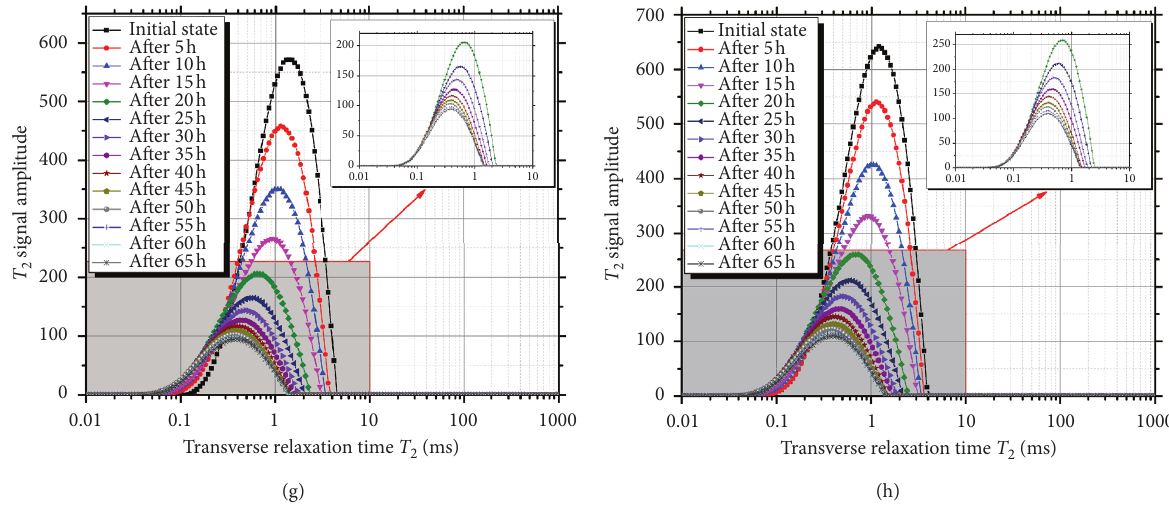
Figure 3: The variations of the T 2 spectra of artificial clayey soils during evaporation: (a) K40; (b) K60; (c) K80; (d) K100; (e) M40; (f) M60; (g) M80; (h) M100.